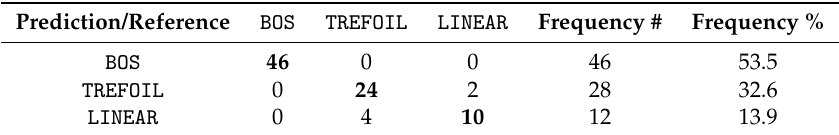
Table 5. Results on large logo detection on an unseen validation dataset, performed by Adidas team. The numbers of correct predictions per class (on the main diagonal of the matrix) are highlighted in boldface font.